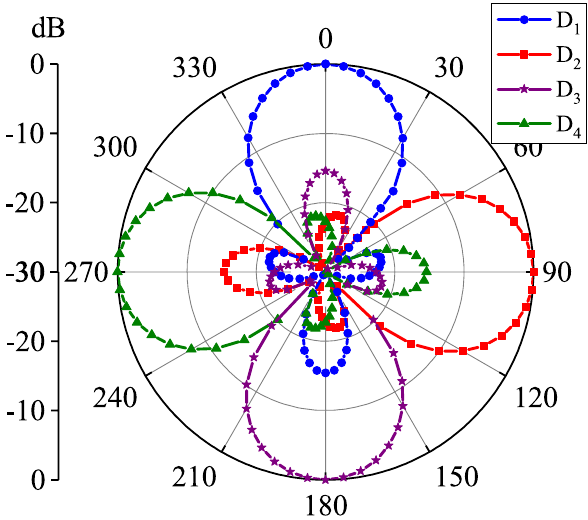
Figure 6. The normalized radiation pattern of the graphene THz antenna in four working